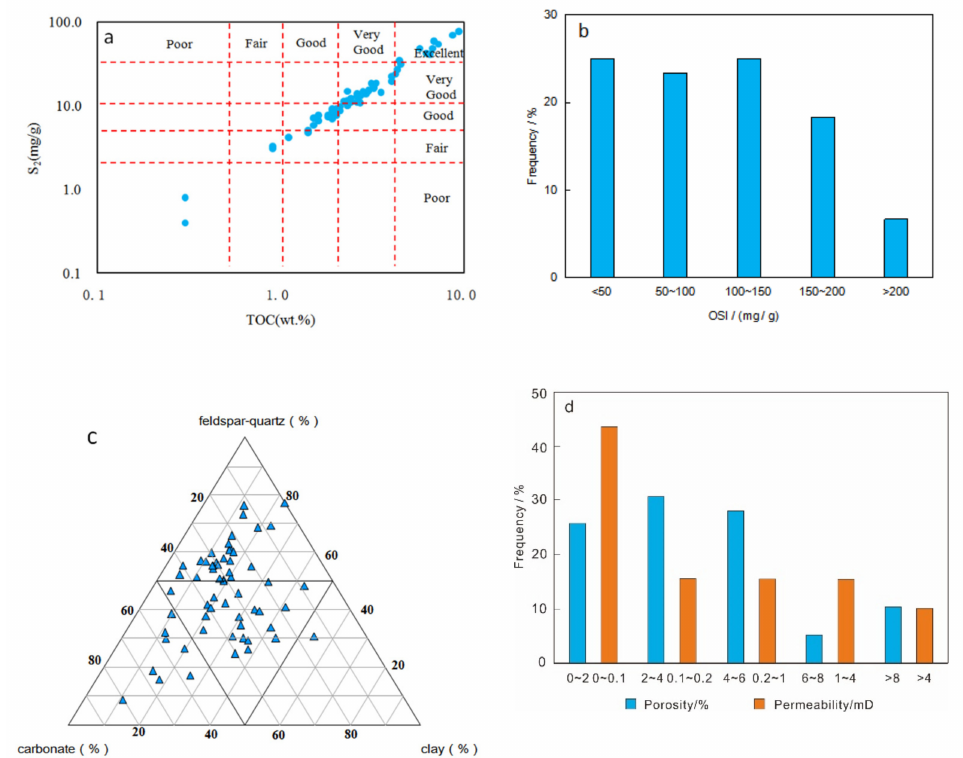
Figure 2. ( a ) Pyrolysis S 2 (the pyrolyzate amount released from kerogen) versus total organic carbon (TOC) plot diagram (modified after [37]); ( b ) frequency histogram of OSI; ( c ) ternary plots of mineral contents of the second Member of Kongdian Formation in Cangdong Sag. ( d ) Porosity and